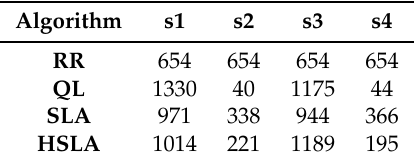
Table 10. Server (feeder link) selection count for Scenario-3